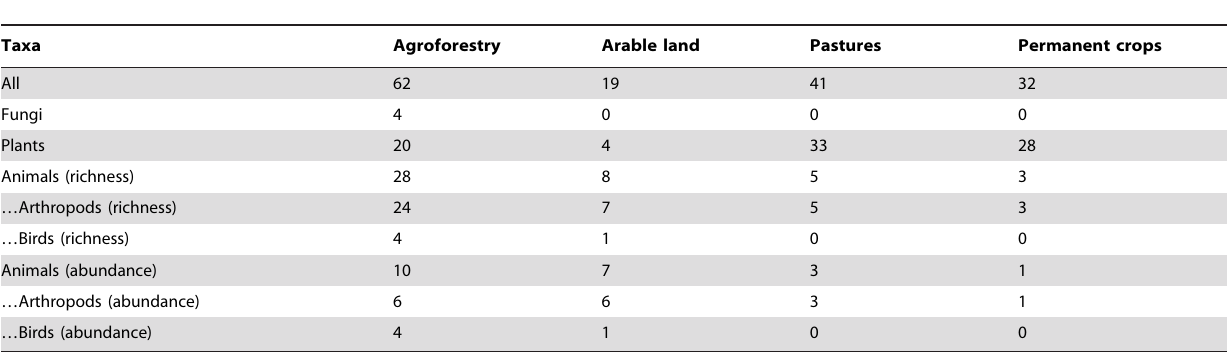
Table 2. Structure of the data set for comparing managed versus abandoned farmlands (number of cases).